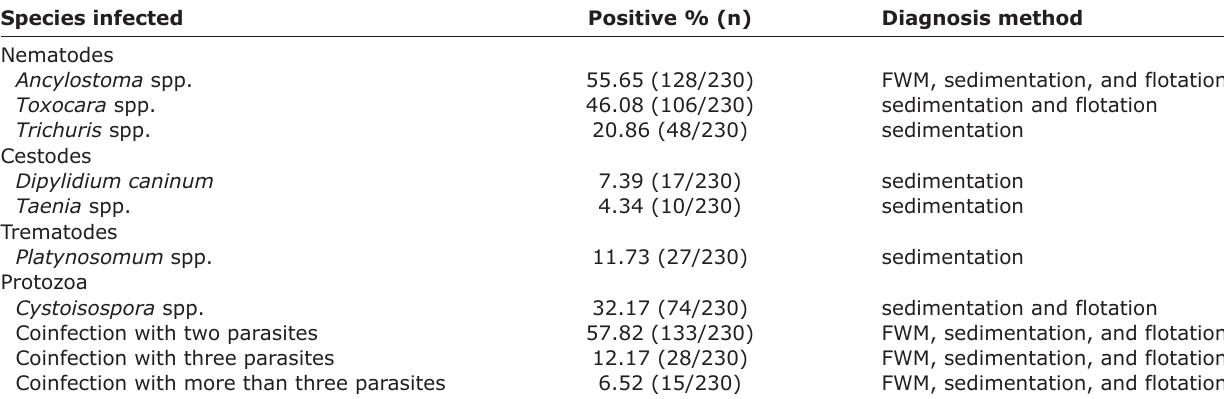
Table-4: The prevalence rate for different parasites such as cestodes, nematodes, trematodes, and coccidia among owned and sheltered cats from Yangon, Myanmar. Species infected Positive % (n) Nematodes Ancylostoma spp. FWM, sedimentation, and flotation Toxocara spp. Trichuris spp. Cestodes Dipylidium caninum Taenia spp.